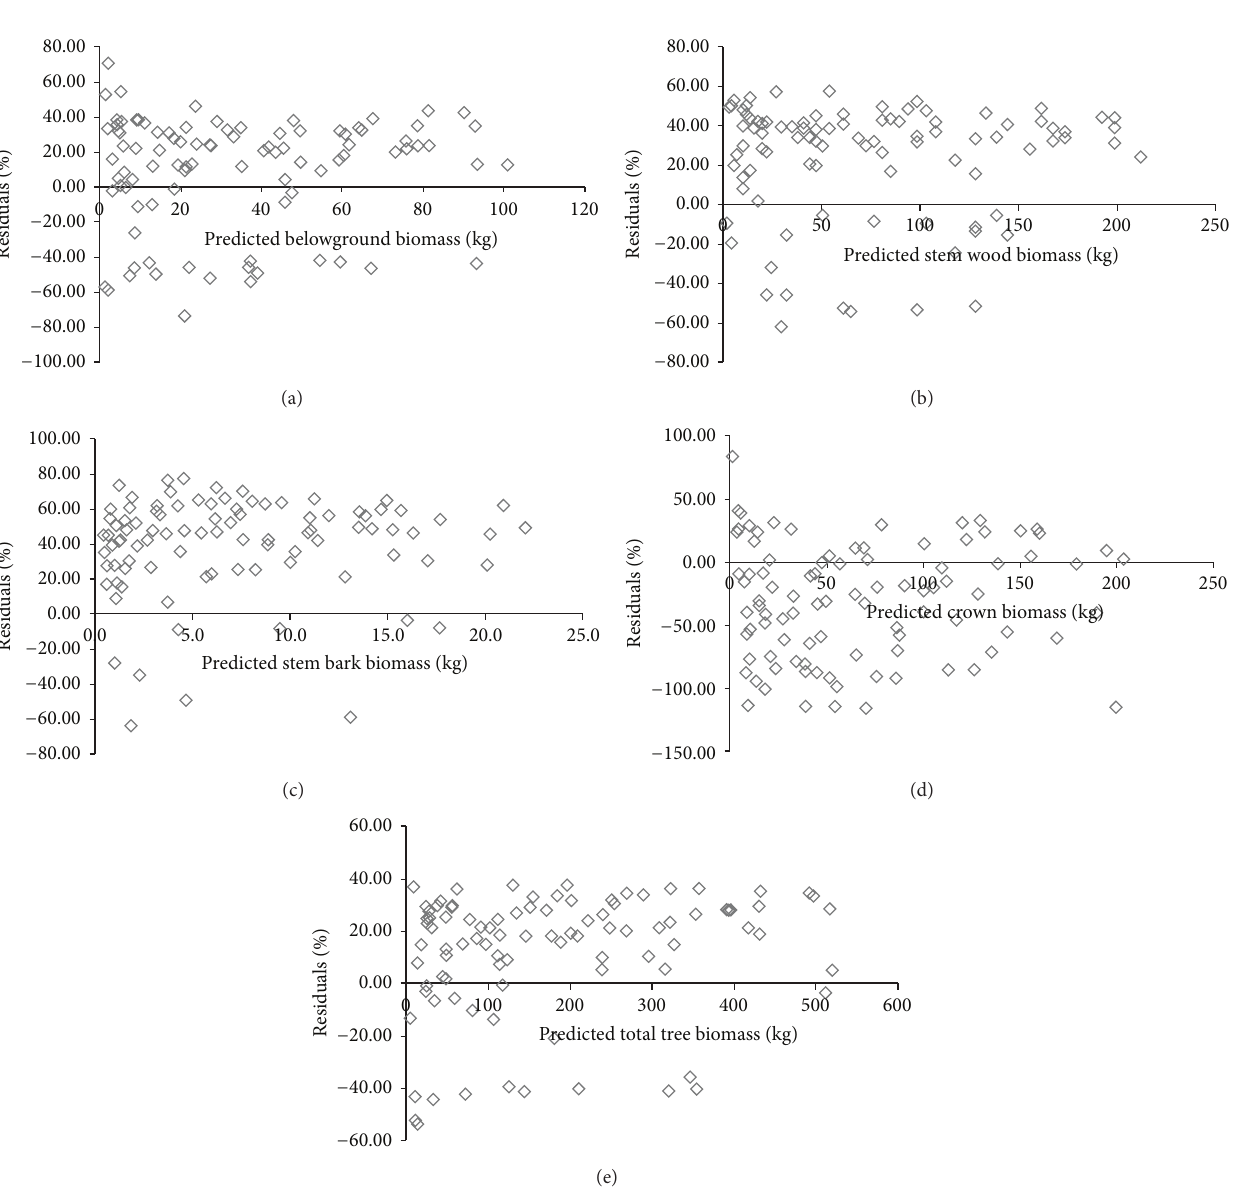
Figure 3: Residuals against the predicted biomass for the SUR method: (a) belowground, (b) stem wood, (c) stem bark, (d) crown, and (e) total tree